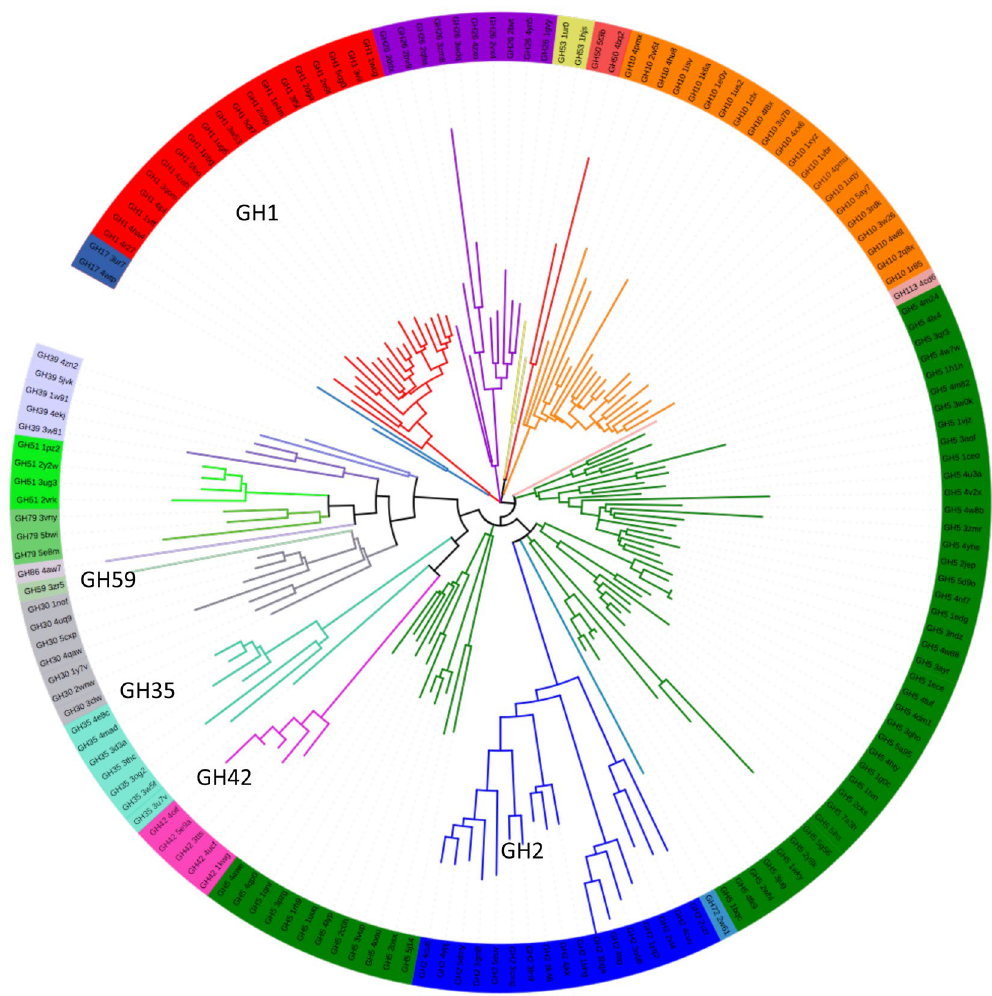
Figure 2. Clan GH-A structural diversity tree. Upon sequence clustering of all Clan-GH PDB entries on a sequence 50% identity basis, independent pairwise structural alignments of the backbone atoms (N, C α , C, O and C β ) were performed with MaxCluster for each structural pair. Structural distance 1-MaxSubAverage score was estimated from the average the non-symmetrical MaxSub scores obtained for each pair. A structural distance tree was determined by neighbor-joining, and visualized using iTOl (http://itol.embl.de). The leafs indicate the GH family and the PDB code. Leaf background and branch colors reflect the different Clan GH-A families with structural data. The clan families having β -galactosidases structures are indicated: GH1, GH2, GH35, GH42 and